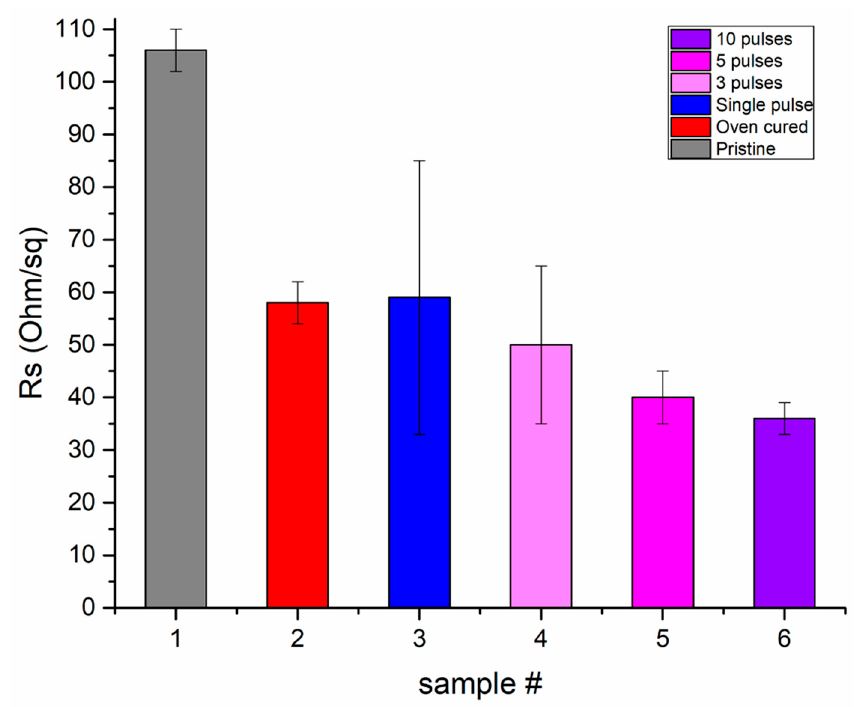
Figure 7. Rs of the pristine Ag NW network layer, after oven baking at 110 °C and post-Laser Curing for 4 different samples: single pulse, 3, 5 and 10 pulse irradiation. In each sample 10 different pixels have been measured. Bars indicate Rs variations from the average value for each case.